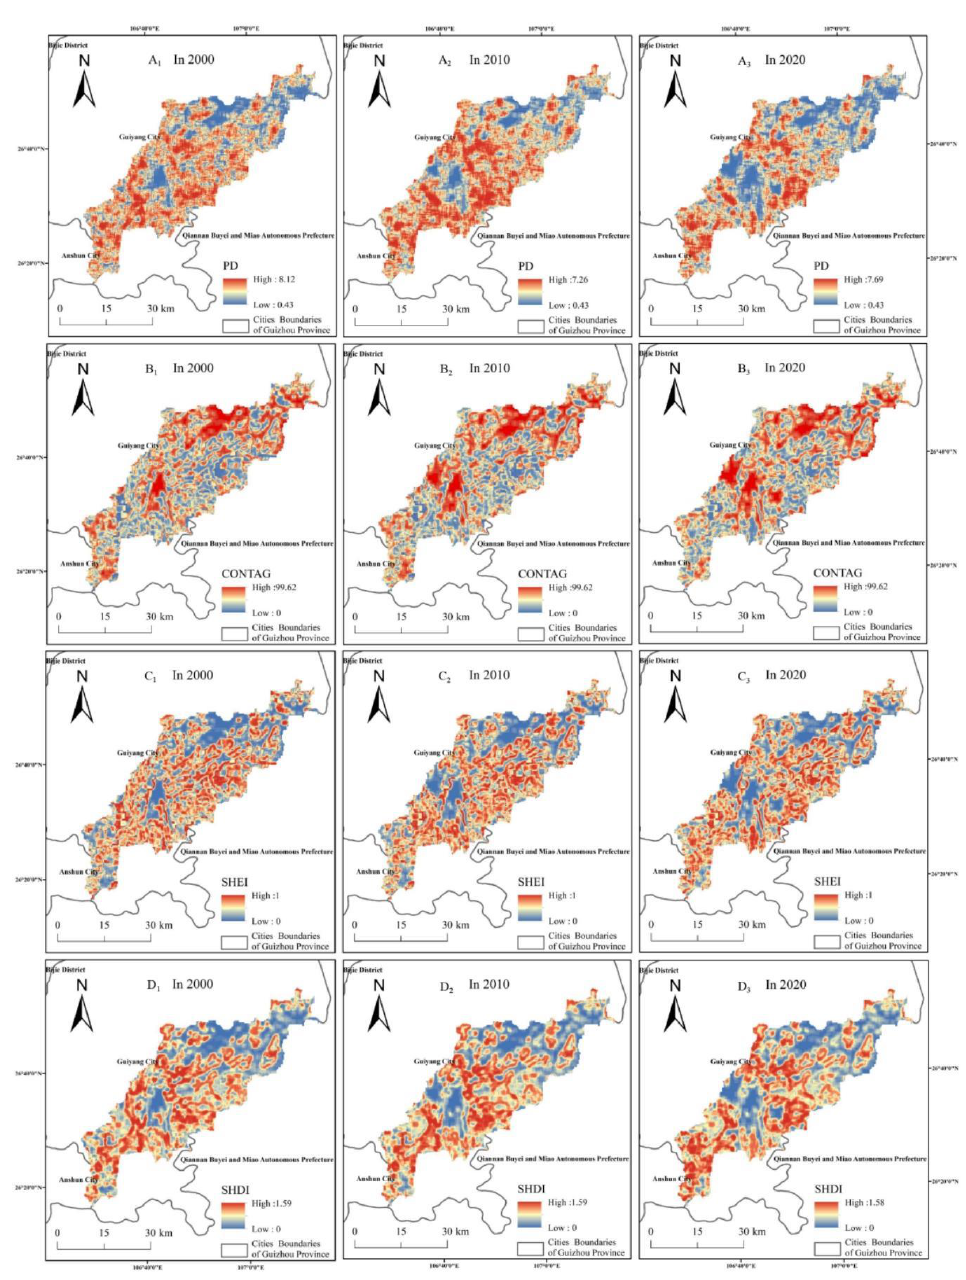
Figure 6. Spatial distribution of landscape pattern index at landscape level in the Nanming River Basin from 2000 to 2020. Note: ( A 1 ) PD in 2000; ( A 2 ) PD in 2010; ( A 3 ) PD in 2020; ( B 1 ) CONTAG in 2000; ( B 2 ) CONTAG in 2010; ( B 3 ) CONTAG in 2020; ( C 1 ) SHEI in 2000; ( C 2 ) SHEI in 2010; ( C 3 ) SHEI in 2020; ( D 1 ) SHDI in 2000; ( D 2 ) SHDI in 2010; ( D 3 ) SHDI in